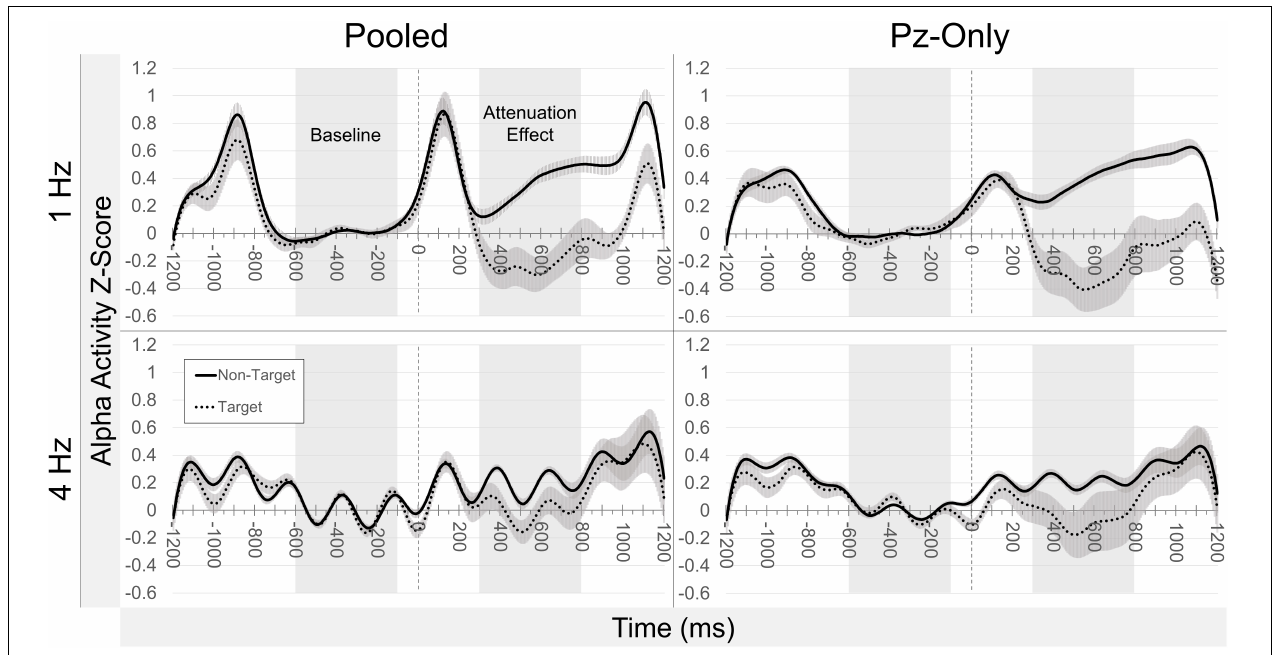
FIGURE 4 | Grand average alpha activity. Waveforms illustrate continuous alpha activity (Z-score) averaged across all participants ( ± SEM), relative to stimulus onset ( t = 0). Plots are separated by condition (presentation rate; stimulus class) and electrode source (pooled occipitoparietal sites; Pz-only). Highlighted regions of the waveforms are indicative of baseline and the measured effect